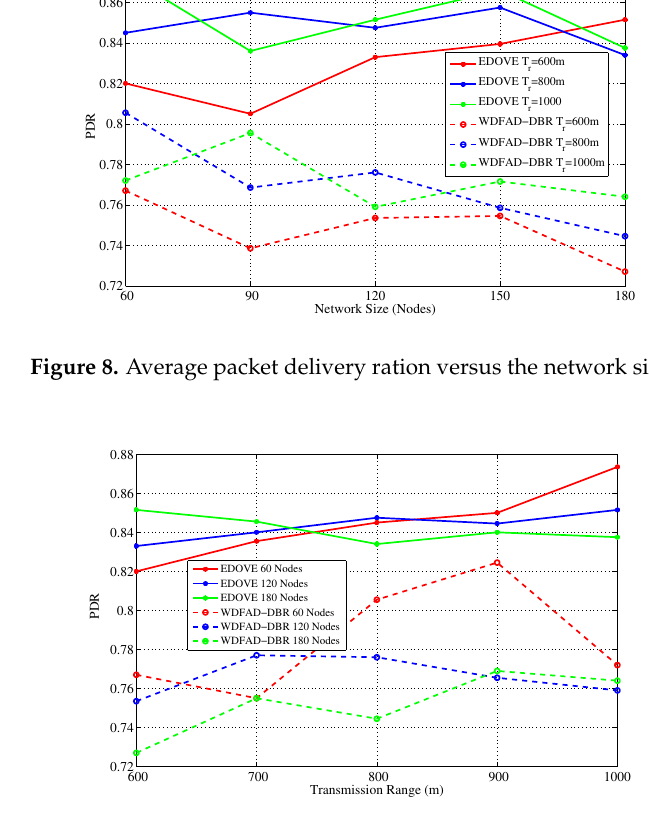
Figure 9. Average packet delivery ration versus the transmission